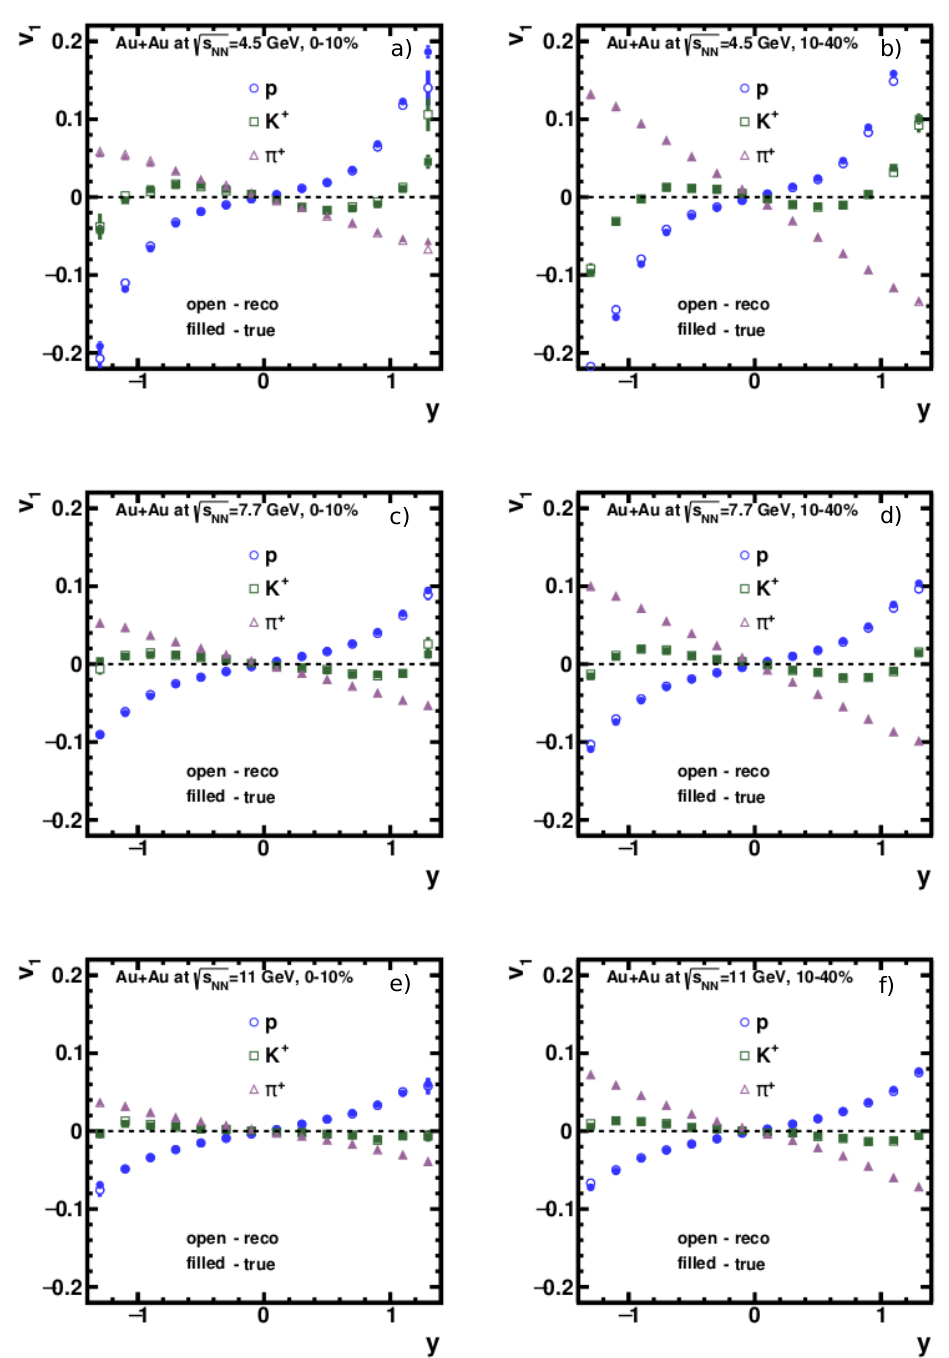
Figure 9. Rapidity y dependence of directed v 1 of charged pions, kaons and protons for 0–10% central ( left panels) and 10–40% central ( right panels) Au + Au collisions at open symbols correspond to v 1 results from the analysis of the fully reconstructed events “reco” and closed symbols to the results from generated “true” UrQMD